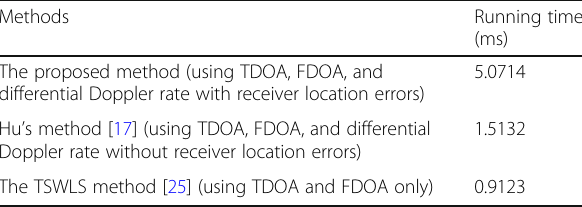
Table 2 The comparison of the method in terms of average running time